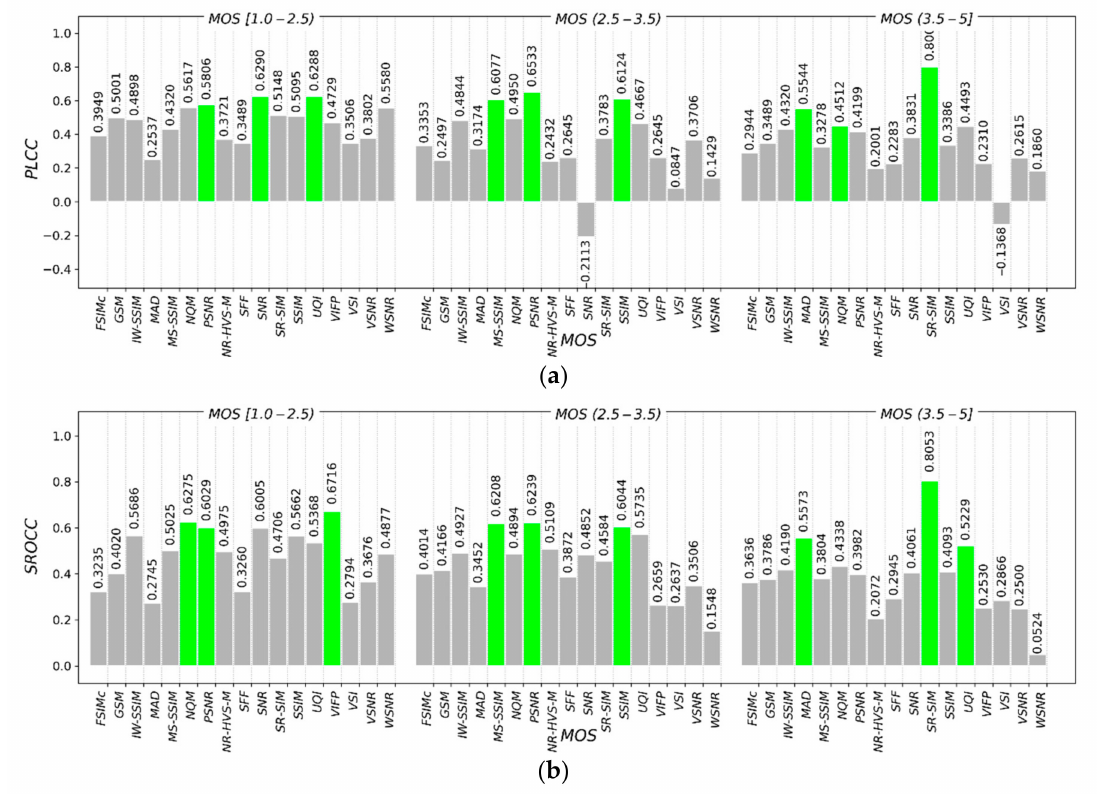
Figure 9. Comparison of the correlation values between di ff erent quality groups of MOS scores and FR-IQA measures (the top three best results are highlighted in light green for each quality group): ( a ) PLCC , and ( b ) SROCC